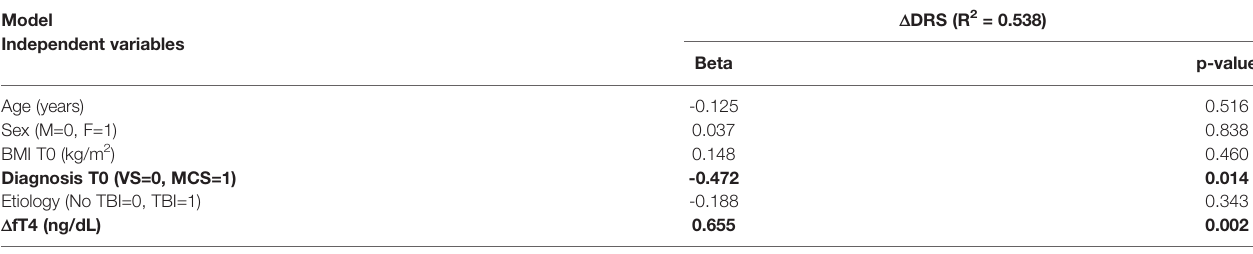
TABLE 4 | Multivariable linear regression analysis showing independent predictors for D DRS. Model Independent